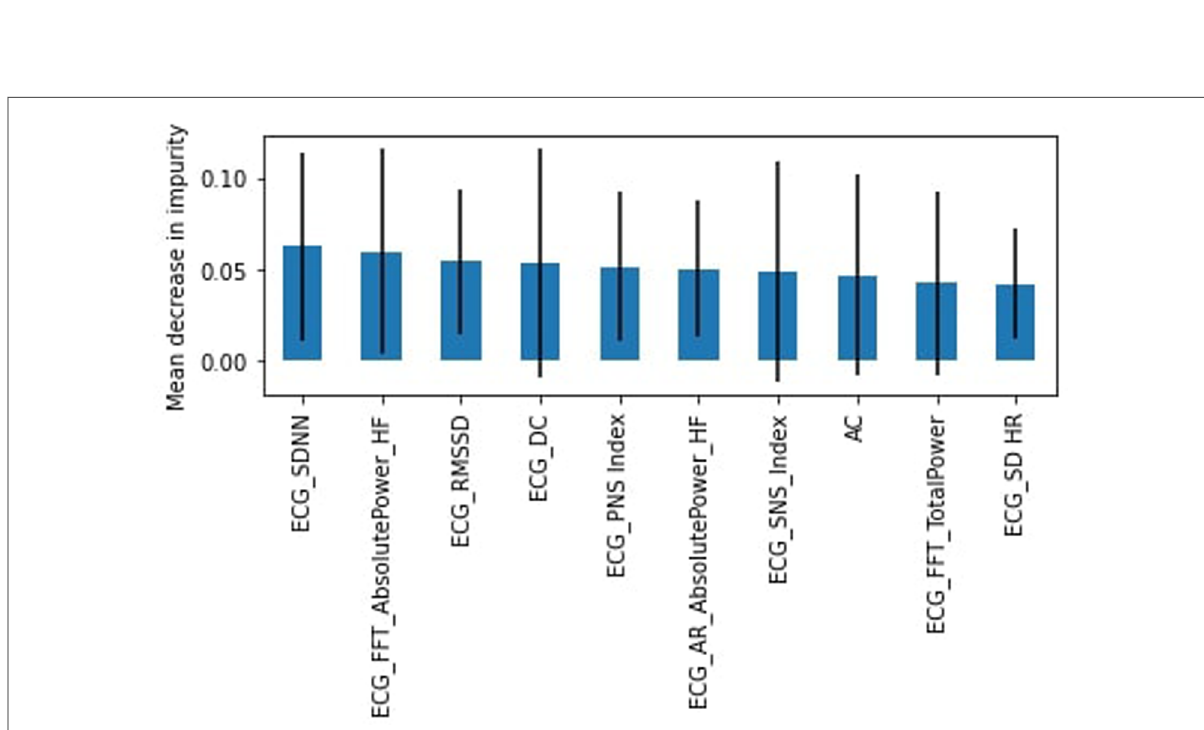
FIGURE 11 RF feature importance, female